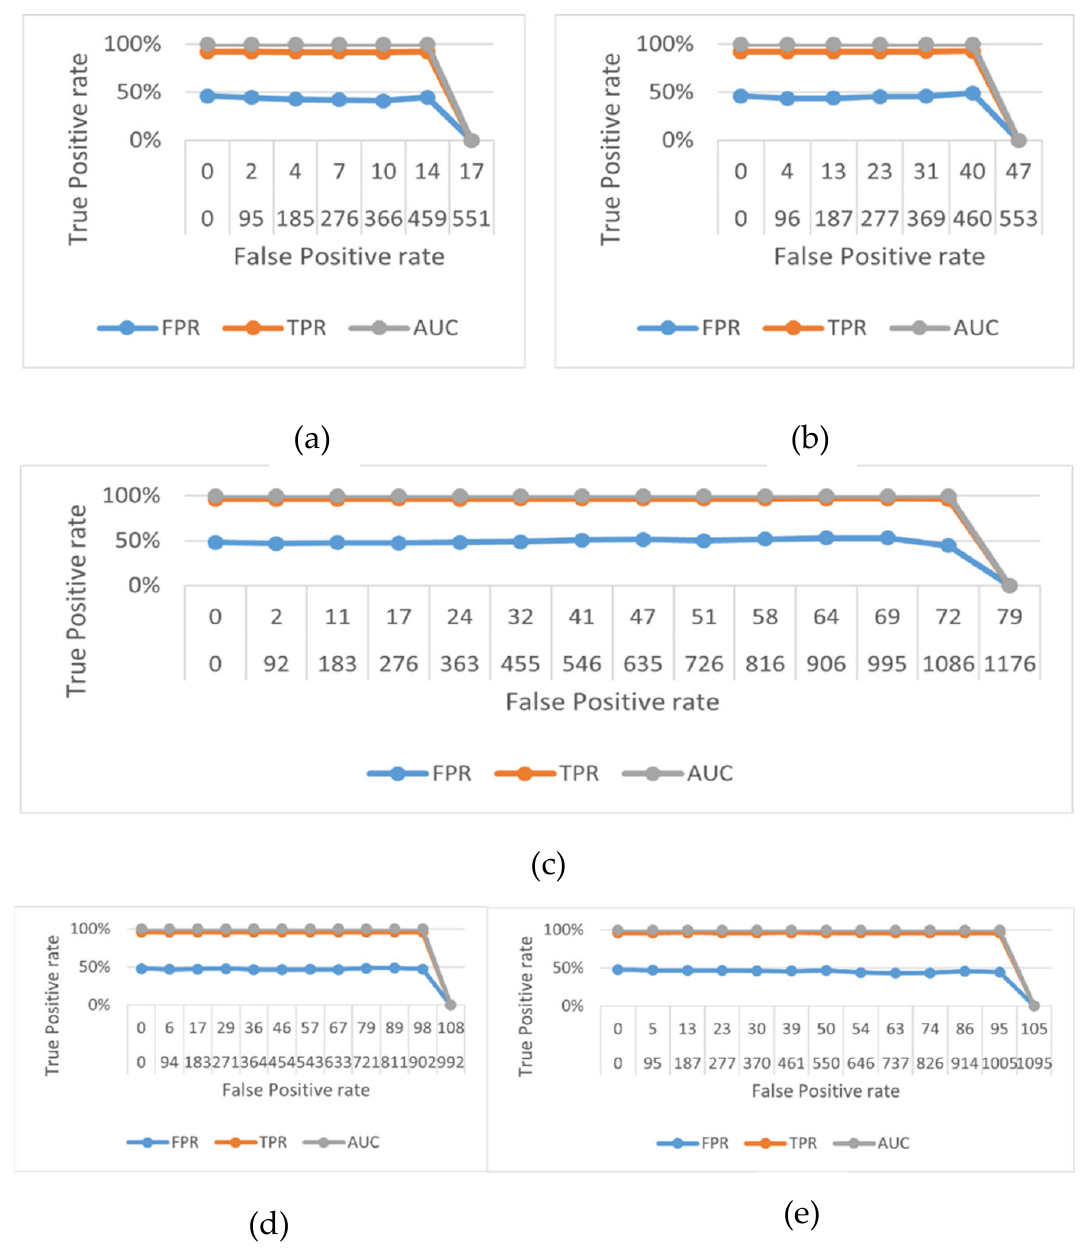
Figure 11. Receiver operating characteristic (ROC) curve on the ( a ) UCI HAR dataset, ( b ) MOTION-SENSE dataset, ( c ) MobiAct dataset, ( d ) PAMAP-2 dataset, ( e ) IMWSHA dataset.